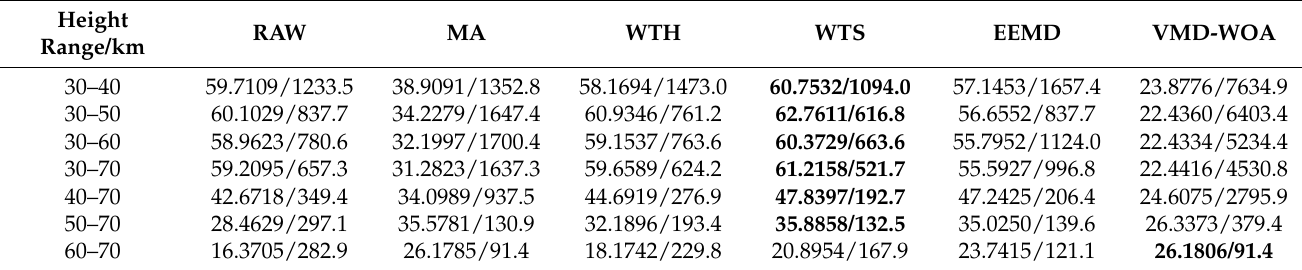
Table 2. Denoising performance with different heights for each algorithm.